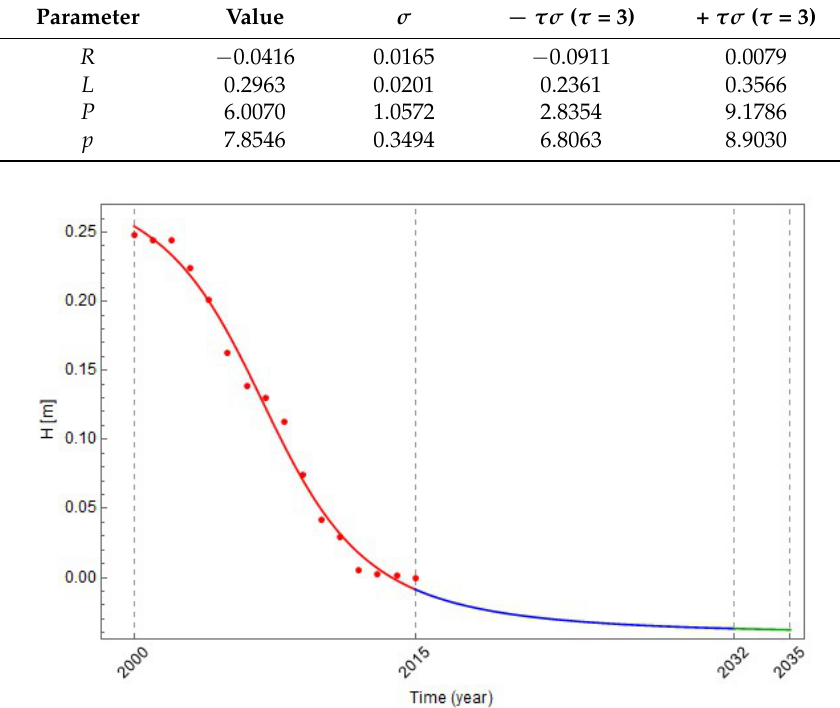
Figure 13. Graphical presentation of results from analysis of vertical displacement of point X1-A1.